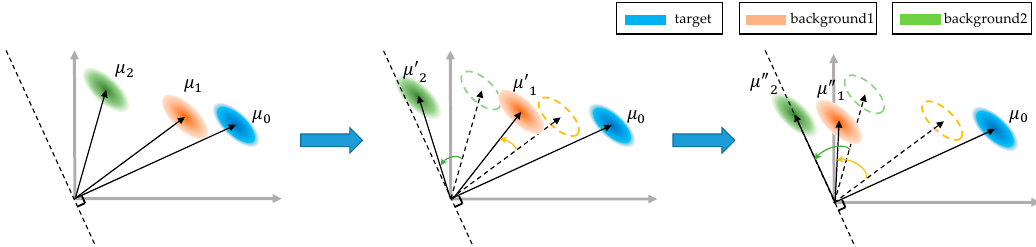
Figure 5. The diagram of background separation in the proposed method. µ 0 , µ 1 , and µ 2 represent the target and two kinds of backgrounds. µ (cid:48) and µ 2 after moving away from the target in the middle and right